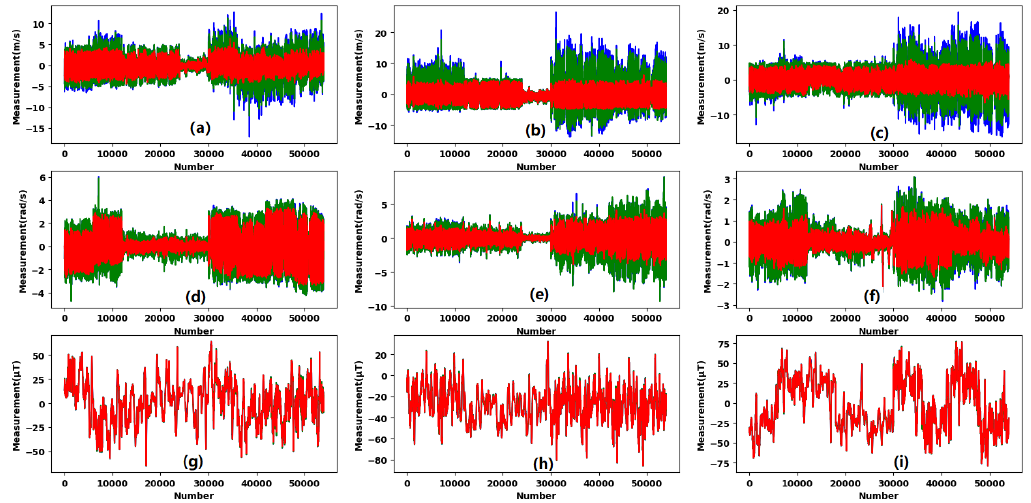
Figure 12. MEMS measurement processing strategies; ( a )–( c ) are filtered accelerometer x -, y -, z -axis measurements; ( d )–( f ) are filtered gyroscope x -, y -, z -axis measurements; ( g )–( i ) are filtered magnetometer x -, y -, z -axis measurements.